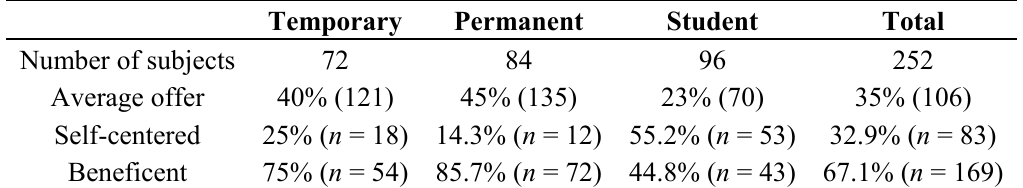
Table 1. Beneficent and self-centered subjects in the Dictator